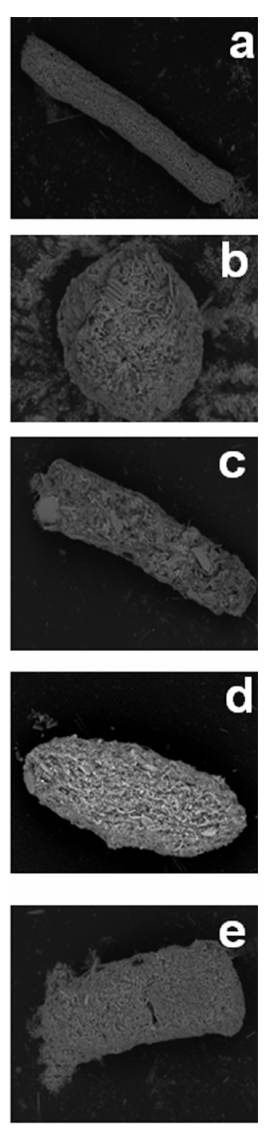
Figure 2. Scanning electron micrographs of the different FP types collected in the sediment traps: (a) cylindrical, (b) round, (c) ellip- soidal, (d) ovoid, (e)